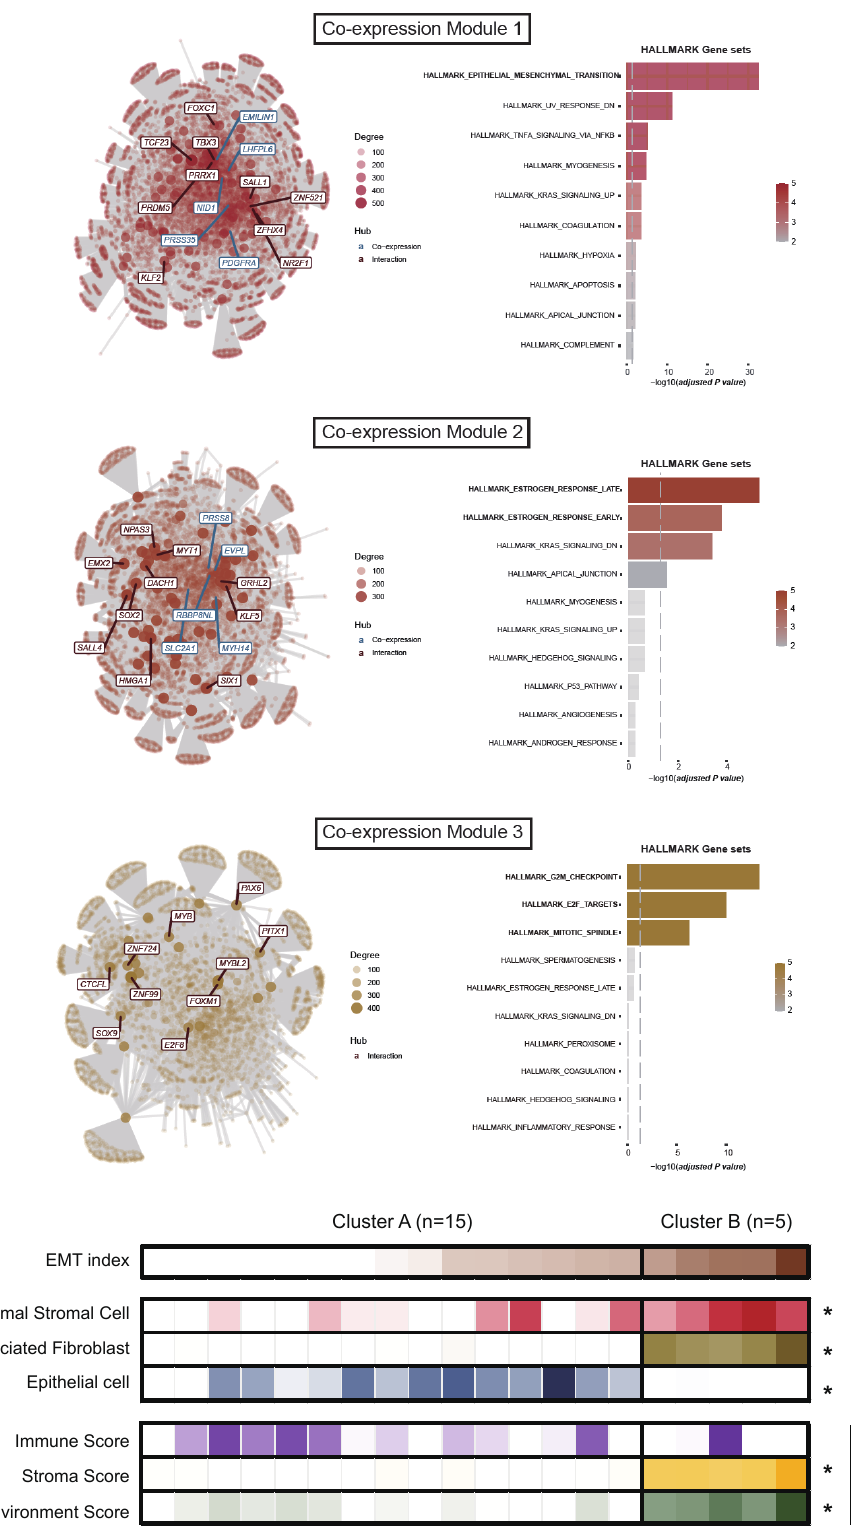
Figure 4. Co-expression gene module identification and cell-type enrichment. ( A ) Interaction network of identified gene modules and over representation analysis using HALLMARK gene sets. ( B ) EMT index and cell-type enrichment analysis results across 20 HGSOC samples divided by cluster A and cluster B and by order of increasing EMT-index. * Mann–Whitney U test p < 0.05 between cluster A and cluster